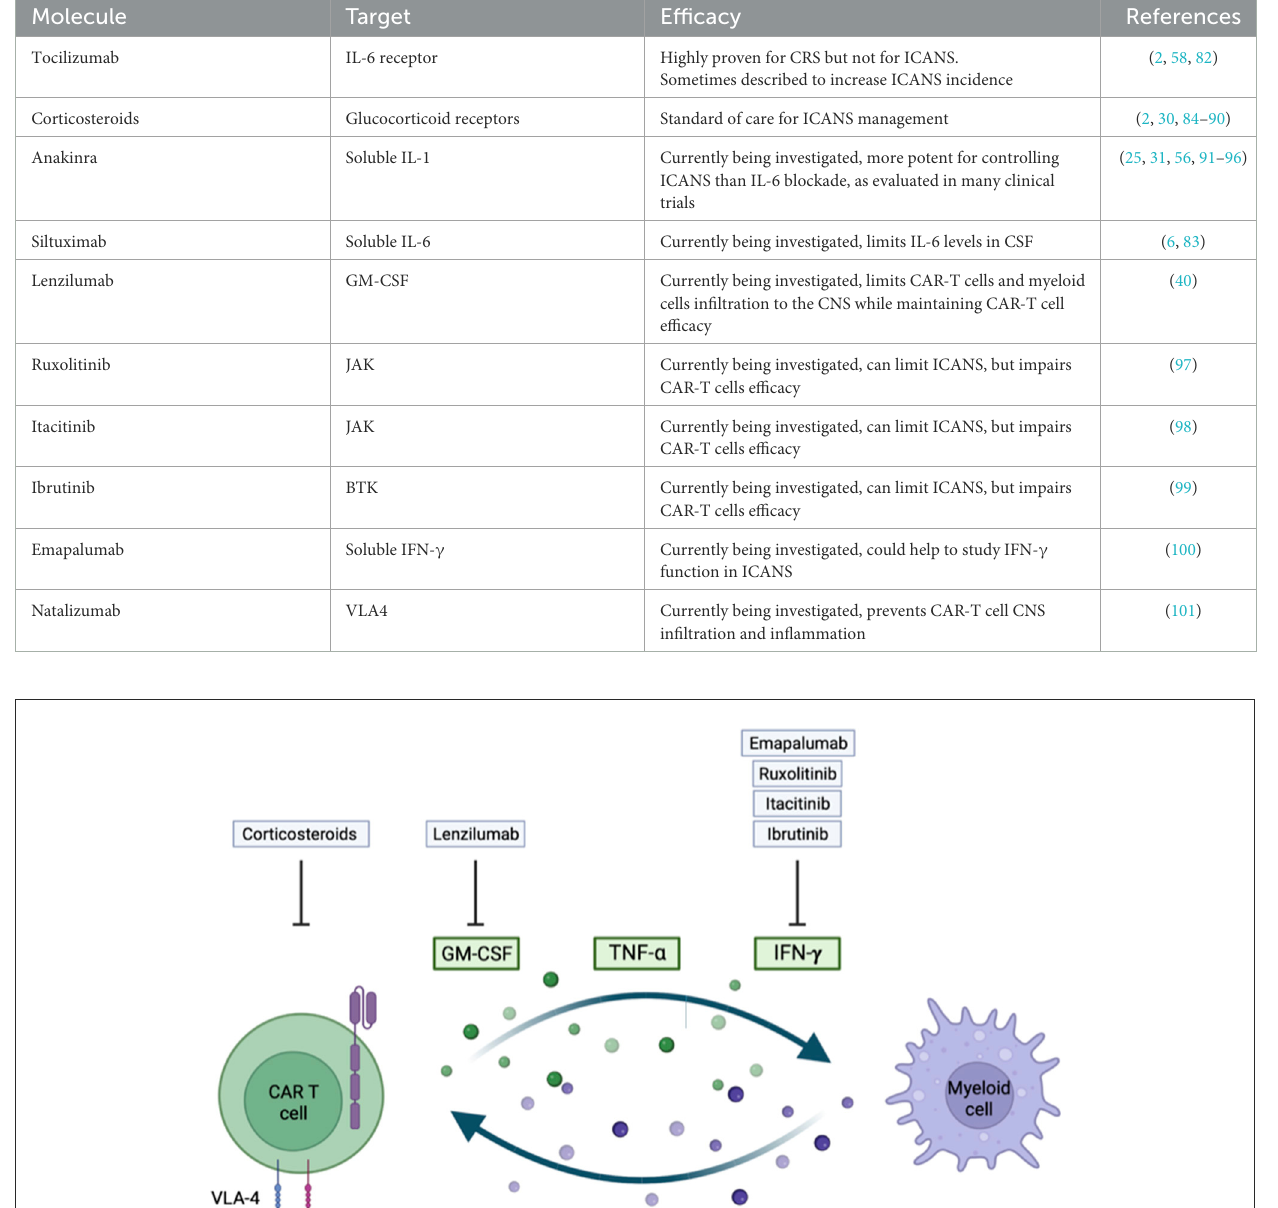
With broader applications and new CAR subsets coming to the clinic, other toxicities will also be observed and will need further adaptation. We already foresee delayed toxicities with BCMA CAR- T cells inducing parkinsonism-like symptoms in some patients (81), which is not described with the most common CAR-T product